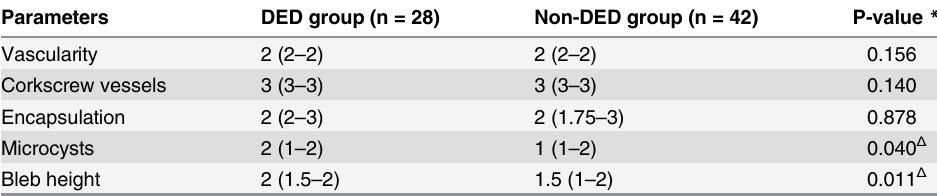
Table 7. Filtering bleb morphology in the DED and non-DED groups.